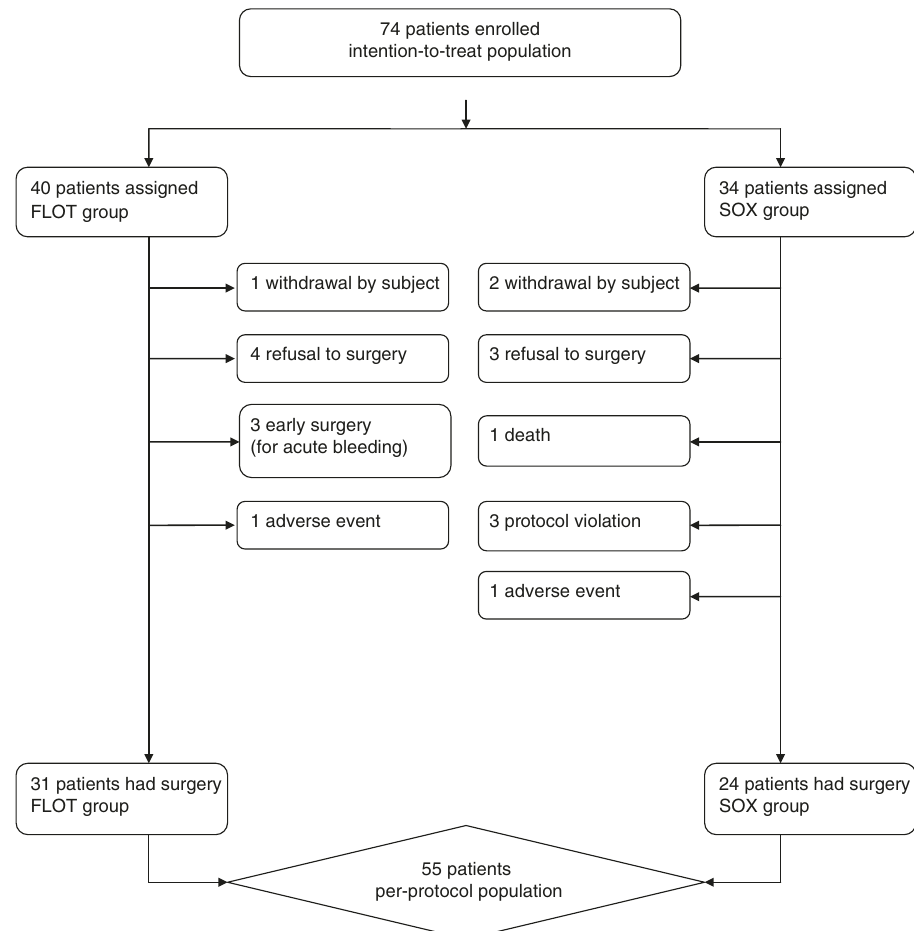
Fig. 1 CONSORT diagram. FLOT docetaxel, oxaliplatin, fl uorouracil, and leucovorin, SOX tegafur – gimeracil oteracil potassium capsule (S-1) plus